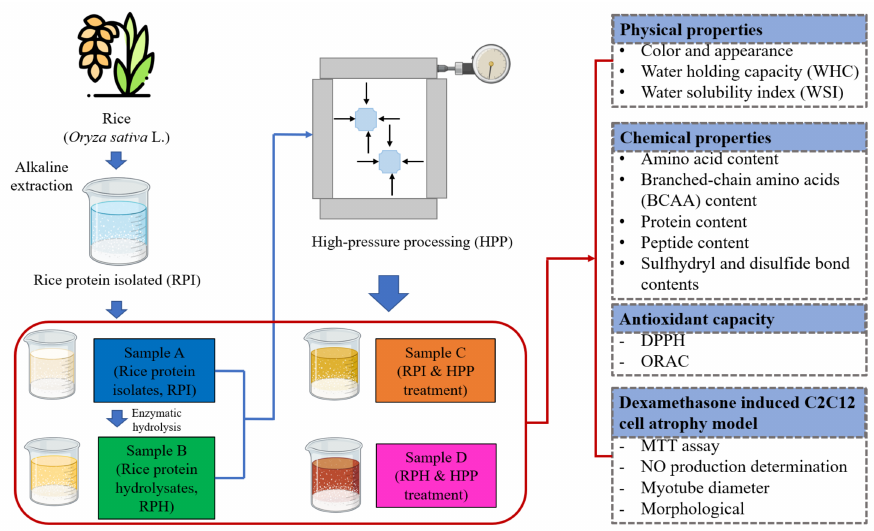
Figure 1. Experimental design and sample preparation methods of rice protein